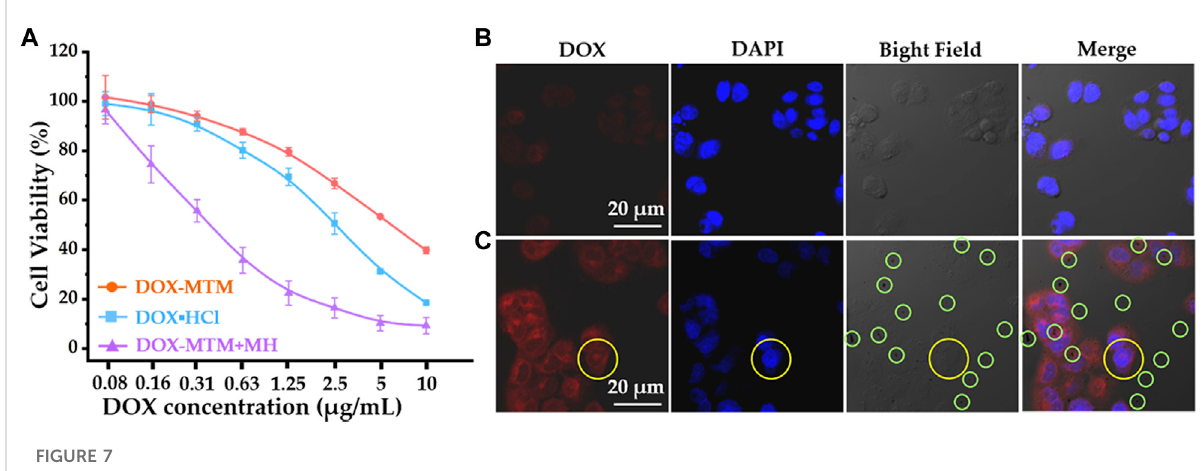
FIGURE 7 The cytotoxicity of 4T1 and cellular DOX uptake under different formulas: (A) cytotoxicity of 4T1 after treating with DOX · HCl, DOX – MTM, and DOX – MTM + MH (MH duration: 10 min, 114 kHz, and 15.9 kA/m); (B) cellular DOX uptake after DOX – MTM treatment for 2 h; (C) the cellular DOX – MTM + MH uptake (the same MH condition as cytotoxicity study) for 2